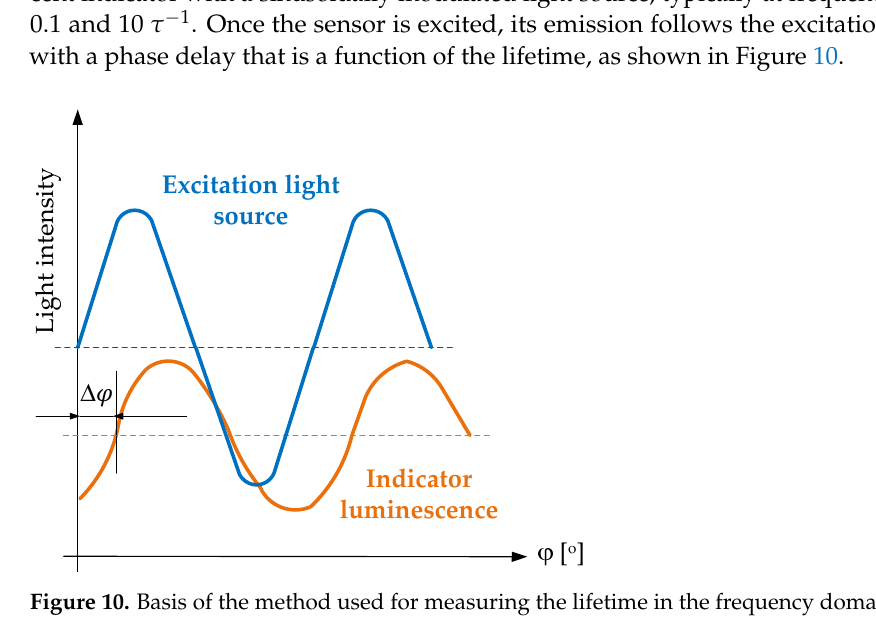
Figure 9. Dynamic response of a luminescent sensor to a pulse of light.